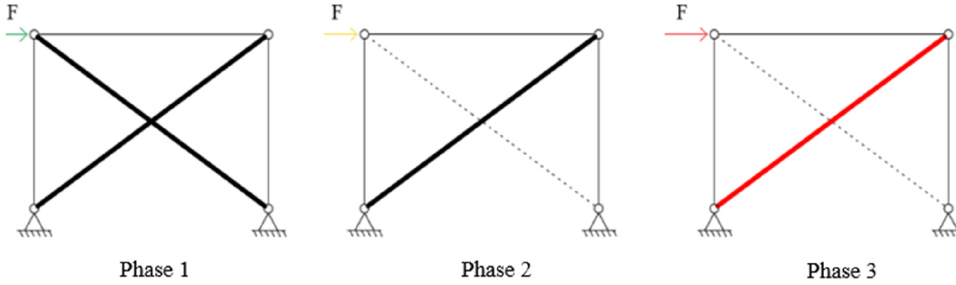
Figure 1. Schematization of the three phases of a CBF response under an increasing load; phase 1: elastic behavior with both diagonals active; phase 2: elastic behavior with a single active diagonal; phase 3: plastic phase.